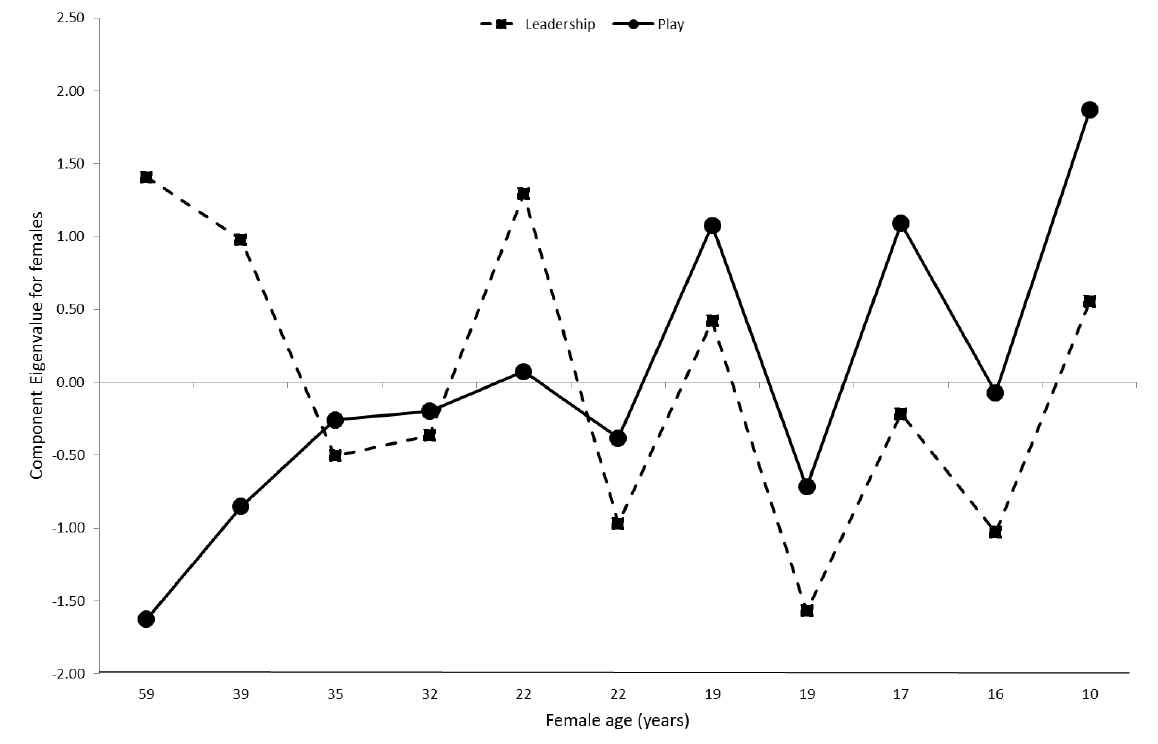
Figure 6. Playfulness, leadership and age in one family of elephants: personality characteristics of adult females (from Lee & Moss,